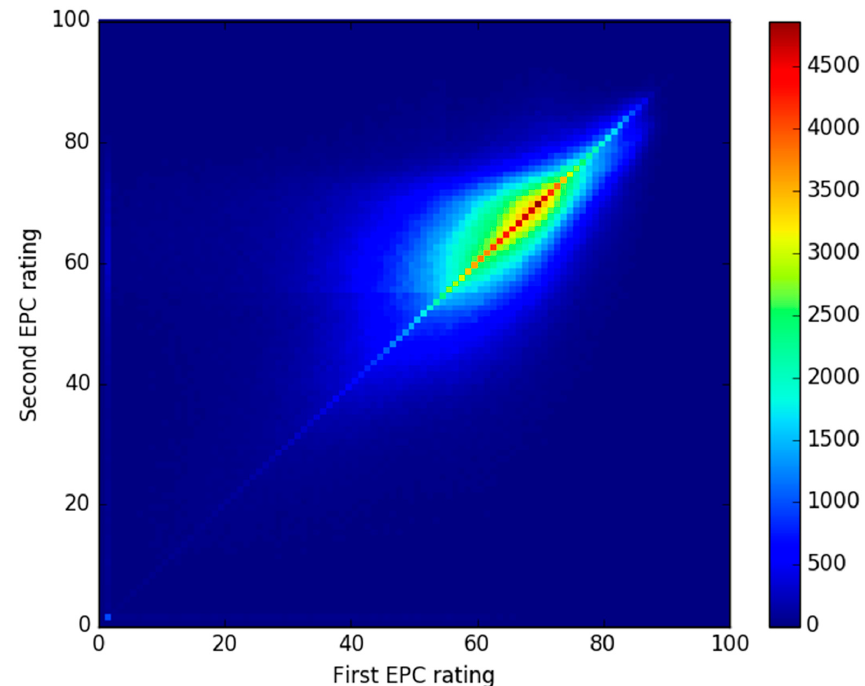
Figure 4. Density plot of first and second EPC ratings for 1.6 million dwellings with two ratings in the England and Wales dataset. Colour indicates number of dwellings.